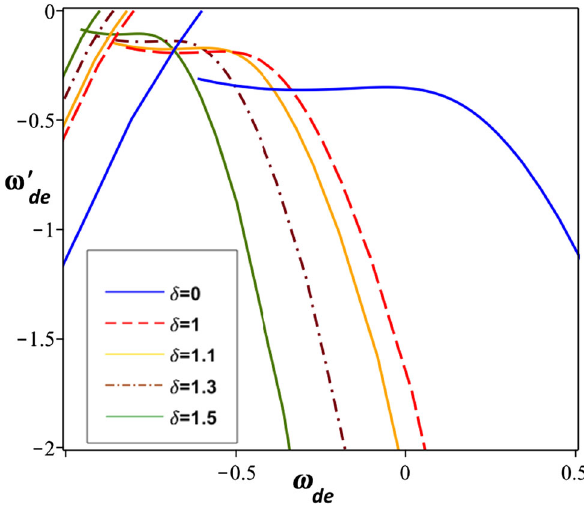
Fig. 4 Plot of ω de − ω (cid:2) plane of non-interacting THDE model for de β = 7 . 1, β = 2 . 15, w = 1000, Ω 0 = 0 . 73 and u = 0 . 1 2 de